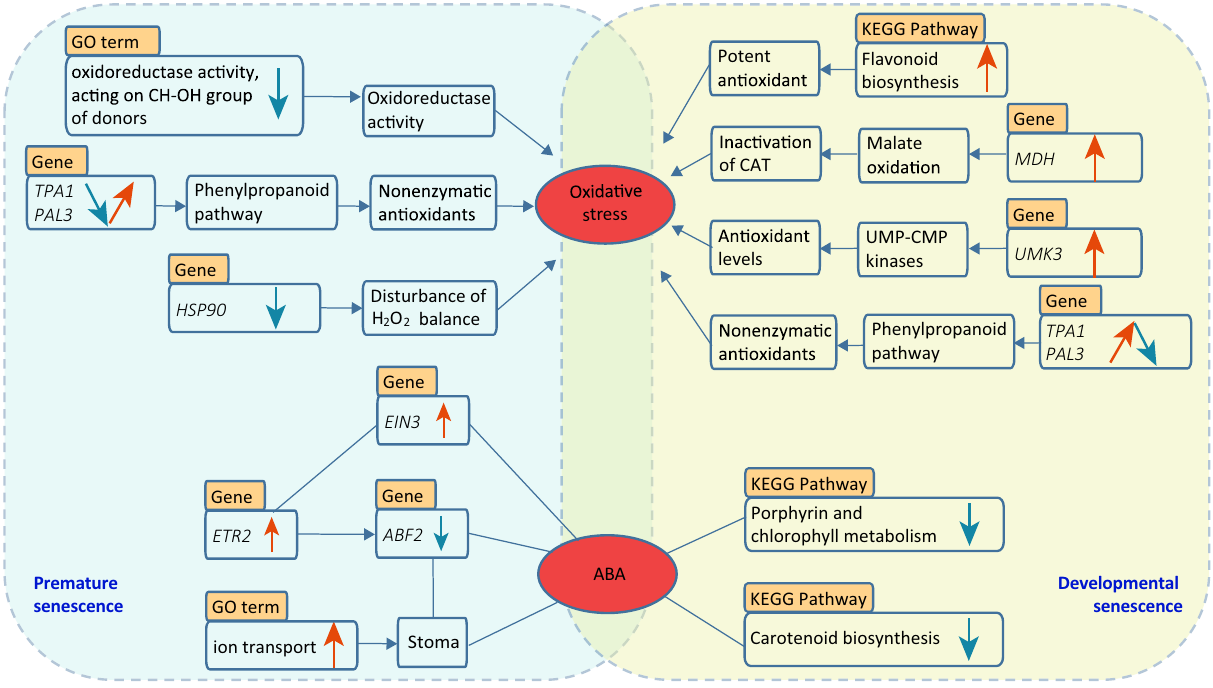
Figure 7. Model of regulatory divergence between DS and PS. The orange and blue arrows in the box represent up and down regulation respectively. Arrows and lines connected boxes indicate the